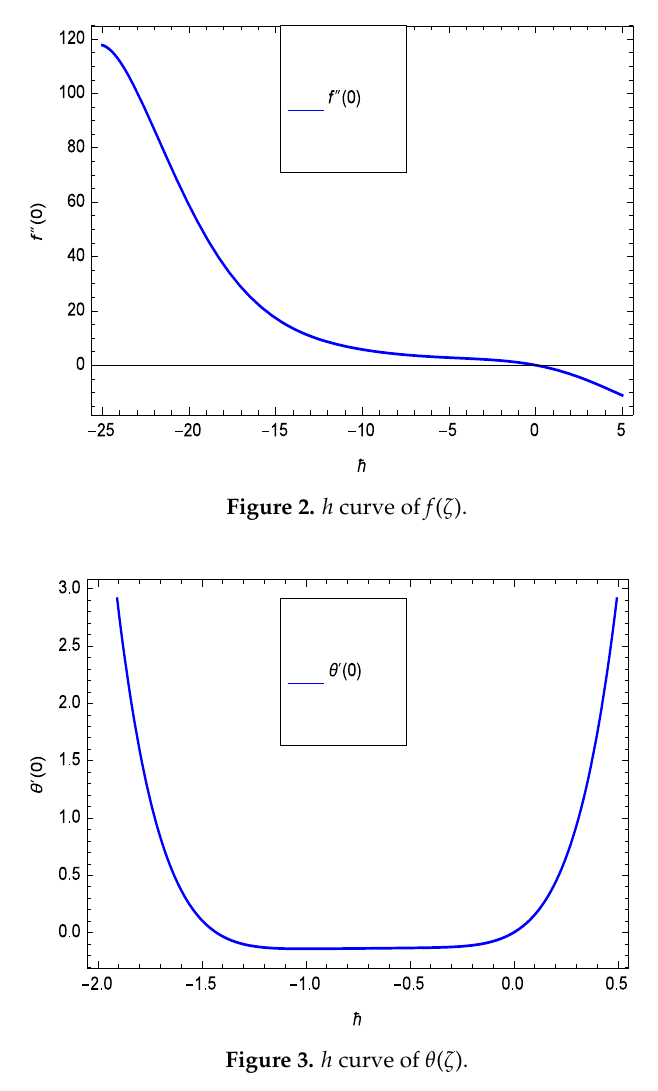
Figure 3. h curve of θ ( ζ